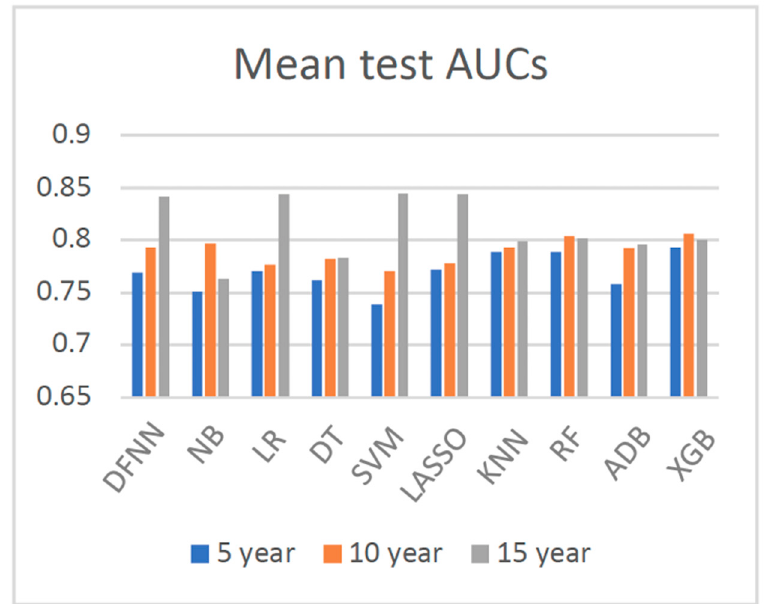
Figure 6. Side by side comparisons of the mean test AUCs of all methods when predicting 5-, 10-, and 15-year breast cancer metastasis (AUC: area under the ROC curves; DFNN: Deep feedforward neural network; NB: Naïve bayes; LR: Logistic regression; DT: Decision tree; SVM: Support vec- tor machine; LASSO: Least absolute shrinkage and selection operator; KNN: K-nearest neighbor; RF: Random forest; ADB: AdaBoost; XGB: